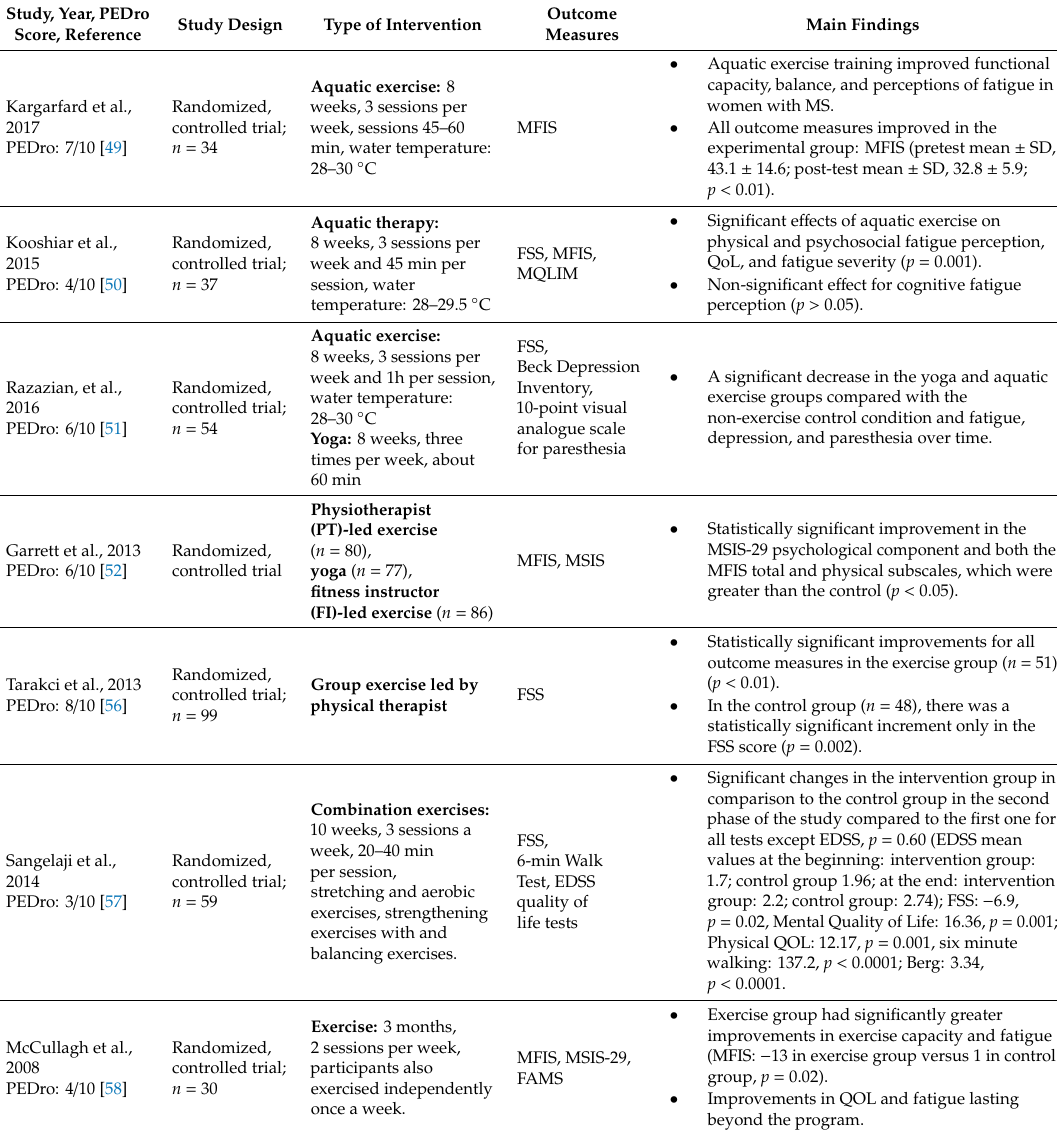
• Aquatic exercise training improved functional capacity, balance, and perceptions of fatigue in women with MS. • All outcome measures improved in the experimental group: MFIS (pretest mean ± SD, 43.1 ± 14.6; post-test mean ± SD, 32.8 ± 5.9; p <